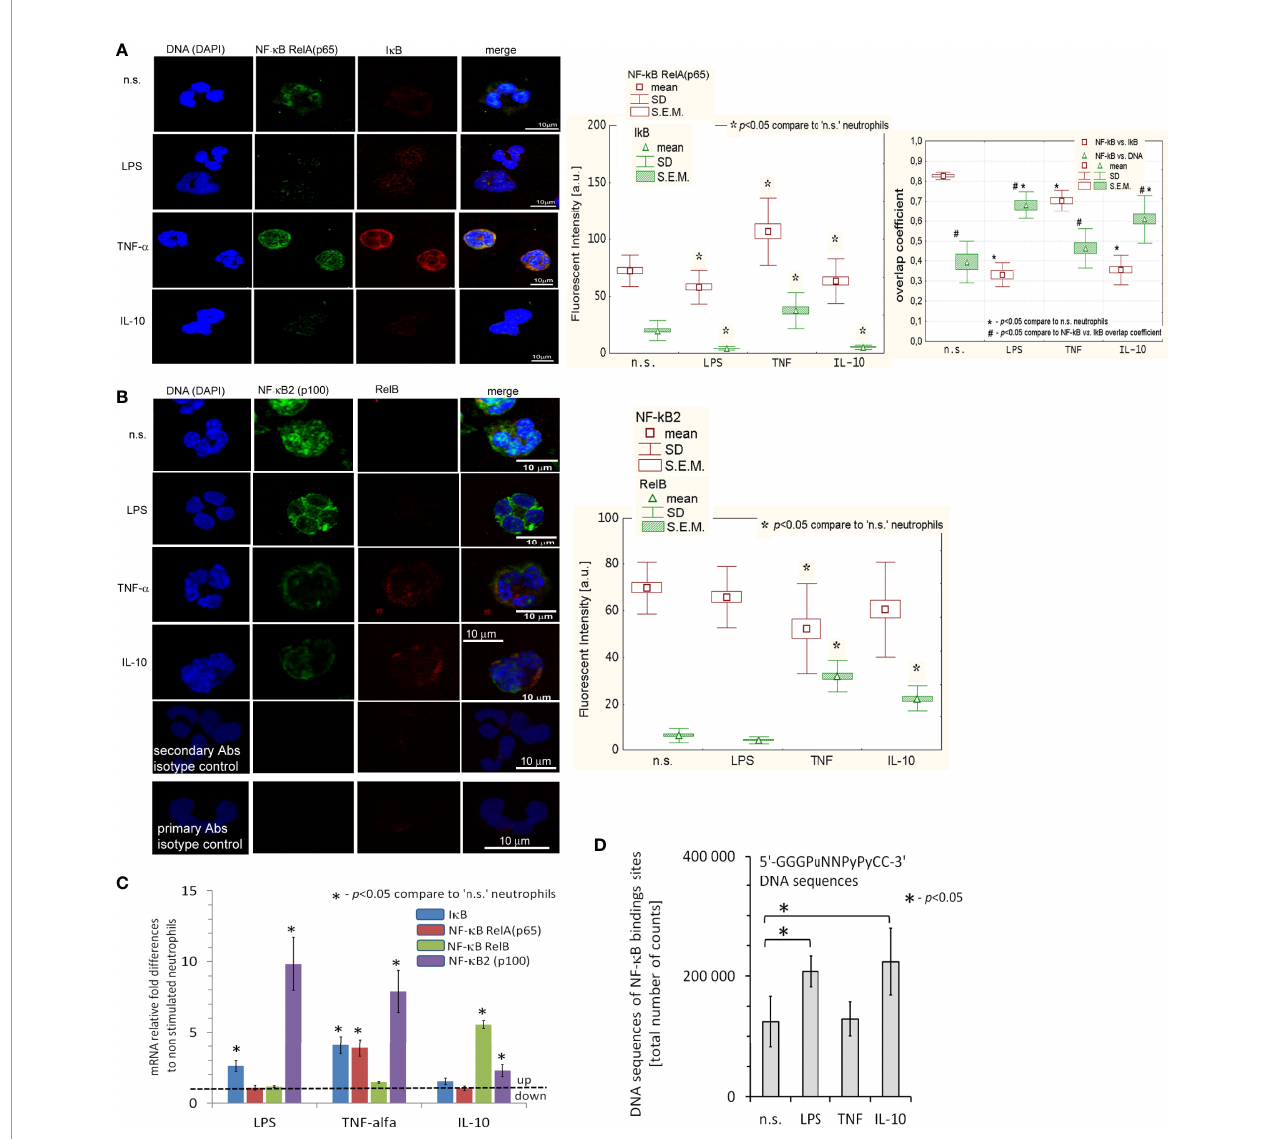
FIGURE 2 | IL-10, LPS, and TNF- a triggered different NF- k B pathways. (A) ICC analysis displayed the neutralization of I k B junction with NF- k B RelA that initiated a migration of RelA (p65) unit to the cell nucleus. (Left panel) An example of ICC analysis. (Middle panel) Analysis of fl uorescence intensity pointed to I k B and NF- k B RelA decrease in LPS- and IL-10-stimulated neutrophils contrary to TNF- a which ampli fi ed synthesis of I k B and NF- k B RelA as well as RelA translocation to the nucleus. The bars represent average fl uorescence intensity ± SD and ± S.E.M. calculated from four independent experiments, using at least 100 single cells for each test. (Right panel) Overlap coef fi cient of NF- k B RelA vs. I k B and NF- k B RelA vs. DNA statistic comparison con fi rmed cleavage of NF- k B RelA bond with I k B after LPS, TNF- a and IL-10 stimulation of neutrophils which resulted in co-localization of RelA (p65) into the cell nucleus. The bars presented average overlap coef fi cient ± SD and ± S.E.M. calculated from four independent experiments. (B) An example of ICC of NF- k B2 and RelB analysis and statistical comparison of fl uorescence intensity. The bars represent average fl uorescence intensity ± SD and ± S.E.M. calculated from four independent experiments using at least 100 single cells for each test. (C) NF- k B RelA, RelB, NF- k B2, and I k B mRNA expression analysis revealed transcription of NF- k B RelA and their inhibitor (I k B) in neutrophils after exposition to TNF- a and LPS, but not to IL-10. In turn, IL-10-stimulated neutrophils initiated RelB mRNA transcription. The graph presents the average values ± SD calculated from four independent experiments. (D) NF- k B DNA binding sites within H3K4me3 in n.s., LPS-, TNF- a -, and IL-10-stimulated neutrophils. The graph presents the average values ± SD calculated from four independent experiments of 5 ’ -GGGPuNNPyPyCC-3 DNA sequences of the total number of counts within H3K4me3- marked histone (Pu, purine; Py,